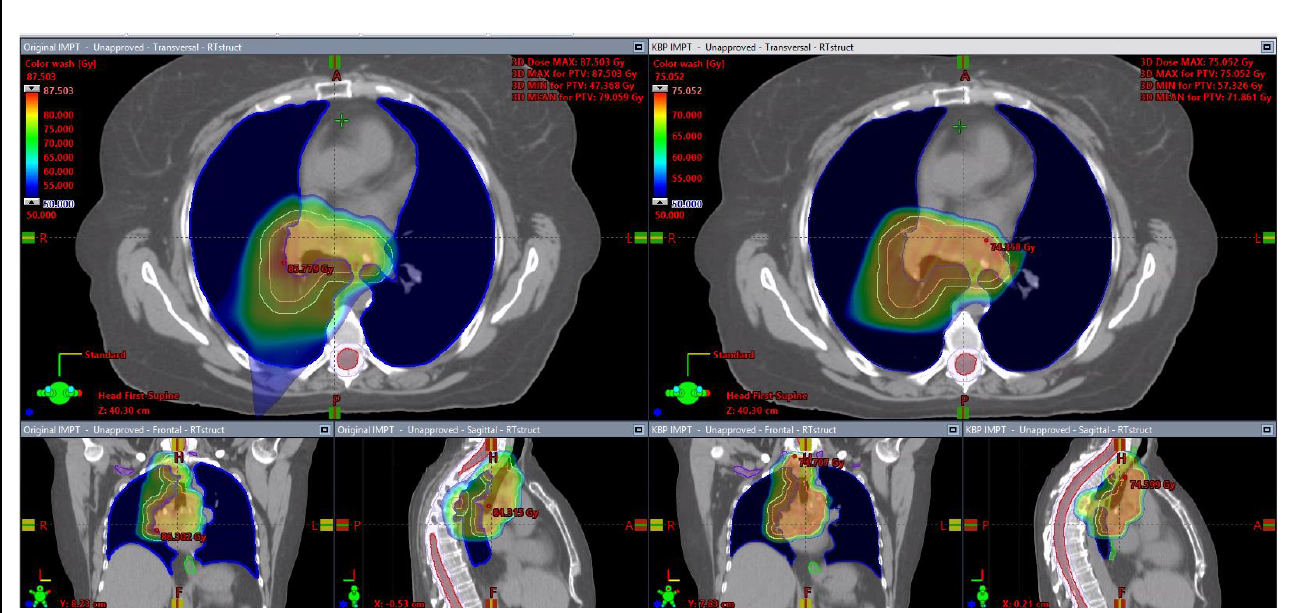
Figure 3. Screen capture of dose color wash comparison of a sample KBP IMPT plan ( right ) versus original IMPT plan ( left ).